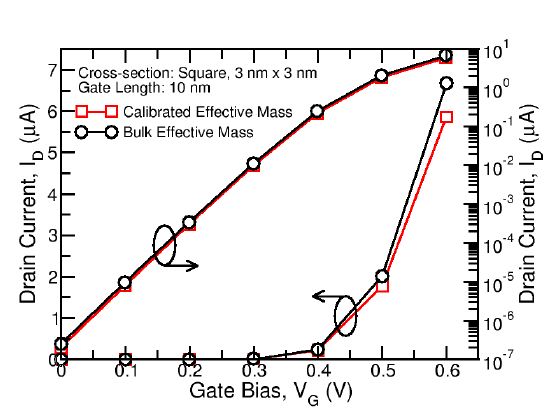
Figure 4. Comparison of the transfer characteristics calculated using the calibrated and bulk effective